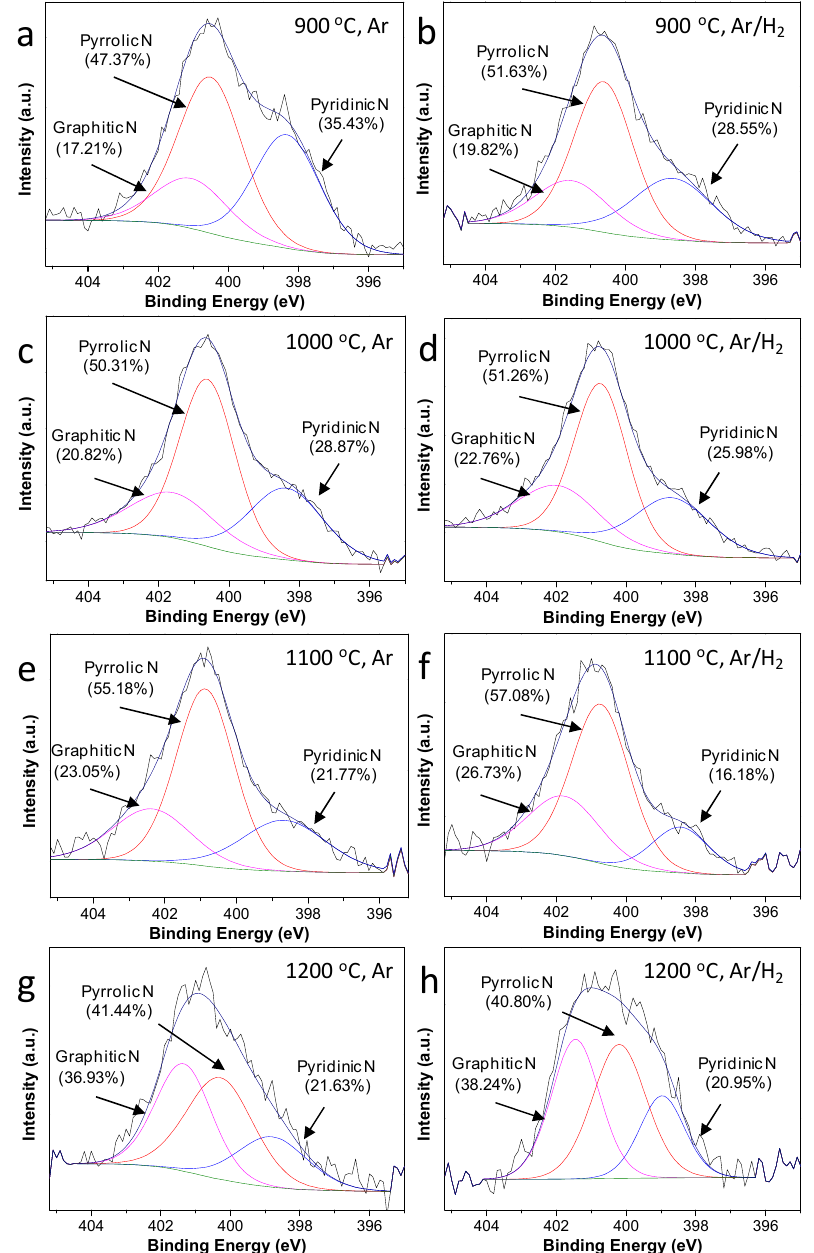
Figure 3. High resolution XPS of N1s peak of (N)G prepared at the pyrolysis temperature of 900 ( a , b ), 1000 ( c , d ), 1100 ( e , f ), 1200 ( g , h ) °C under Ar (left side) or Ar/H 2 (5%) (right side), respectively.